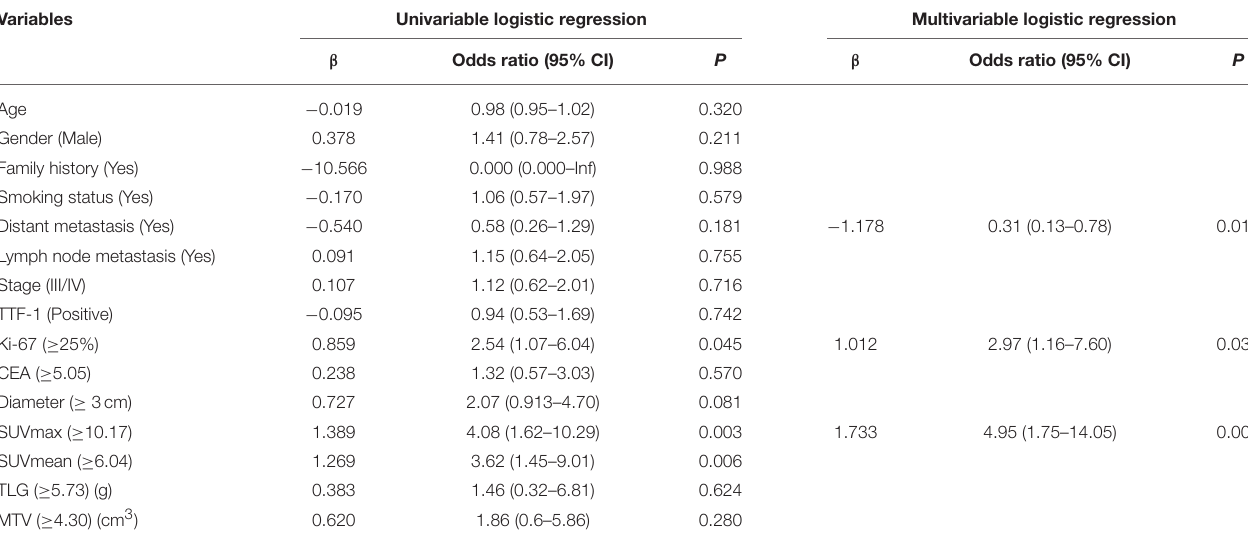
TABLE 4 | The univariate and multivariate analysis of various predictive factors for the pathological subtype in invasive lung adenocarcinoma.